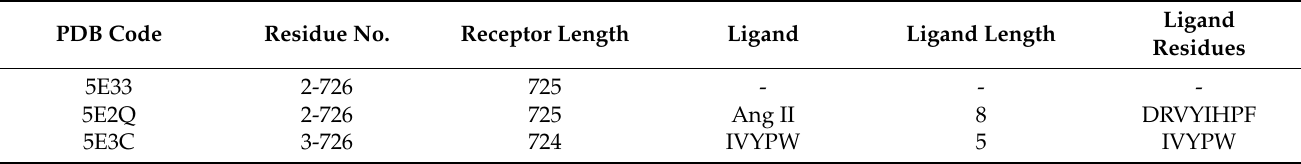
Table 1. Details of the initial structures of the three systems used in this study. (“-” indicates that the ligand of the system was removed for the MD simulations.). PDB